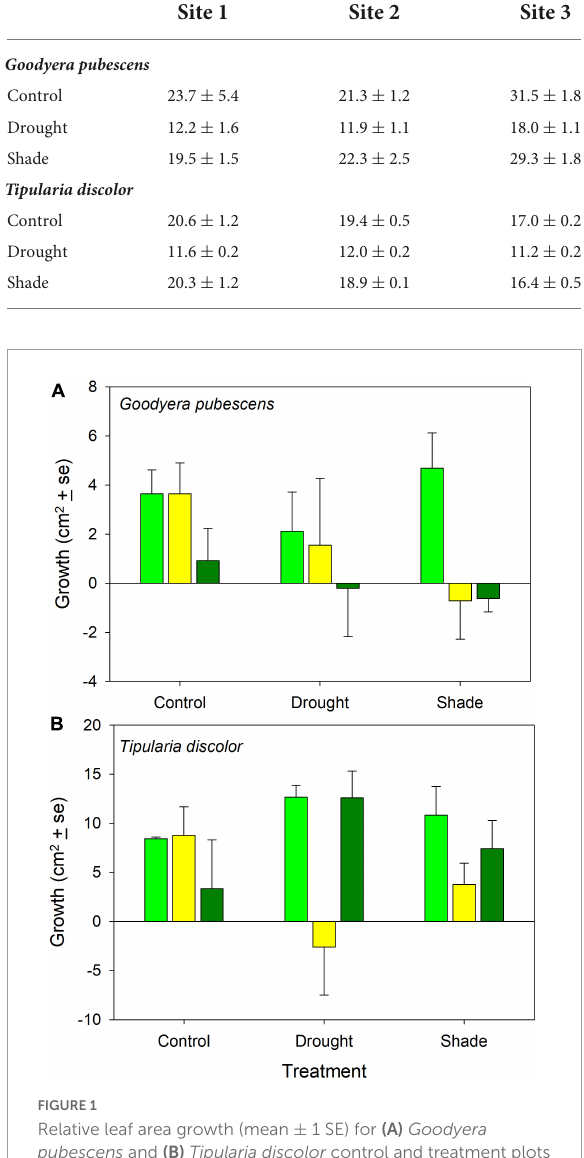
FIGURE1 Relative leaf area growth (mean ± 1 SE) for (A) Goodyera pubescens and (B) Tipularia discolor control and treatment plots at each site. The three bars for the two treatments and controls represent different sites where the experiment was conducted, as described in the section “Materials and